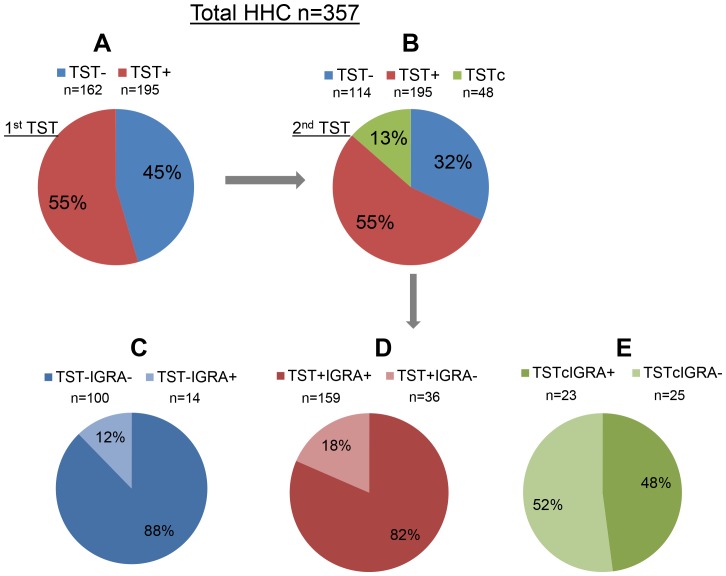
Pie charts show the number and percentage of HHC in each category.IGRA responses were analyzed in the three HHC subgroups (TST-, TST+ and TSTc) and the breakdown is diagrammatically represented.